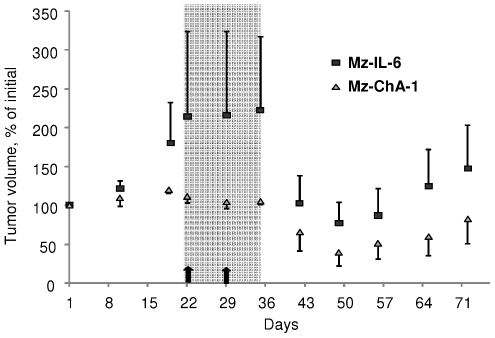
Effect of felodipine and gemcitabine on IL-6 expressing tumor cell xenograft growth.The effect of co-administration of felodipine and gemcitabine on Mz-ChA-1 and Mz-IL-6 tumor cell xenograft growth was assessed. The shaded region indicates the duration of treatment with gemcitabine, 120 mg/kg, every 3 days for 5 doses, whereas the solid arrows indicate the administration of felodipine. Tumor growth was markedly reduced when felodipine was given along with gemcitabine. Thus, felodipine can enhance the effects of gemcitabine on tumor cell growth in vivo. Data represent mean and standard error of normalized estimated tumor volume obtained using caliper measurements from 4 xenografts for each cell type.